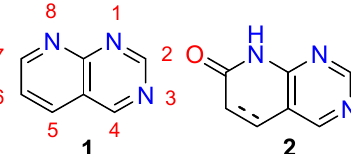
Figure 1. Structures of the pyrido[2,3- d ]pyrimidine ring system ( 1 ) and pyrido[2,3- d ]pyrimidin-7(8 H )-ones ( 2 ).